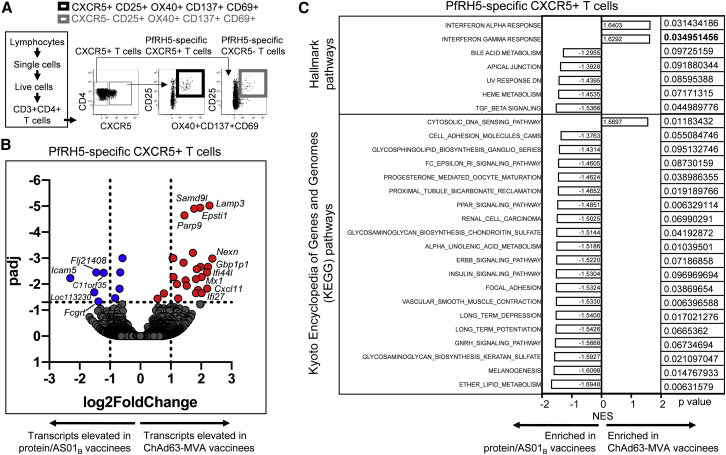
Transcriptomic analysis of PfRH5-specific CXCR5+ cells identifies signatures associated with the superior humoral immune response in protein/AS01B vaccineesPBMCs from 4 weeks following final vaccination from vaccinees receiving PfRH5 delivered using ChAd63-MVA (n = 6) or protein/AS01B (n = 5) platforms were stimulated with a PfRH5 peptide pool (2.5 μL/mL) for 24 h and stained for phenotypic and activation markers.(A) Representative gating strategy for sorting of PfRH5-specific CXCR5+ and CXCR5−CD4+ T cells.(B) Volcano plot illustrating genes that were differentially expressed in PfRH5-specific CXCR5+CD4+ T cells from ChAd63-MVA versus protein/AS01B vaccinees. FDR-adjusted p values are shown on the y axis and log2 fold change on the x axis. Individual transcript names are shown for some points.(C) Results from Gene Ontology enrichment analysis using Hallmark and Kyoto Encyclopedia of Genes and Genomes (KEGG) databases. The network enrichment score (NES) for each pathway enriched or trending to be enriched (p < 0.1) in PfRH5-specific CXCR5+CD4+ T cells from either ChAd63-MVA or protein/AS01B vaccinees is illustrated, together with the p value; p values in bold remained significant after FDR correction (q < 0.05).